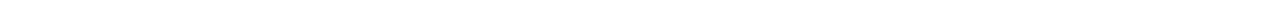
Figure 3 | DNAJB1 is a downstream transcriptional target of FOXE3 and is indispensable for the cell cycle. ( a ) Schematic illustration of the 5 0 UTR of DNAJB1 with golden boxes indicating potential FOXE3-binding sites predicted by ProSuite algorithms. Blue arrows, designated 1–8 F and 1–8 R, represent eight primer pairs used for amplifying regions of interest. ( b ) Amplification of specific segments in the 5 0 UTR of DNAJB1 using pull-down DNA as the template in the amplification reaction. ( c ) HEK293FTcells were transiently transfected with the DNAJB1 -GLuc-SEAP vector and an expression vector harbouring wild-type or mutant (p.E103K, p.N117K and p.C240*) FOXE3 alleles. Error bars represent percent deviation in each data set of luciferase activity normalized against SEAP performed in seven independent replicates for each condition. ( d ) HEK293FT cells were transfected with the wild-type or mutant FOXE3-expressing plasmids in a pT-Rex-DEST30 vector and expression levels of DNAJB1 were quantitated with TaqMan assays. Error bars represent s.d. in each data set of the DNAJB1 expression normalized against GAPDH, analysed in six independent replicates. ( e ) HLE cells were transfected with either scrambled (i–iii) or DNAJB1 shRNA (iv–vi), and the increase in apoptotic cell population in response to shRNA-targeting DNAJB1 was assessed 48h post transfection. ( f ) Increased apoptosis resulting from downregulation of DNAJB1 was estimated through flow cytometry of TUNEL stained cells 48h post transfection of DNAJB1 shRNA. The loss of DNAJB1 results in increased apoptosis in HLE cells resulting in a threefold increase in TUNEL-positive cells compared with the control cells transfected with scrambled shRNA ( P o 0.000005; 2-tailed student’s t -test). Error bars represent s.d. in each data set analysed in four independent replicates. ( g ) The effect of the downregulation of DNAJB1 on the G0 population was examined through flow cytometry of propidium iodide-stained cells 48h post transfection of DNAJB1 shRNA. The DNAJB1 shRNA-transfected cells exhibited a significant increase in the G0 population as compared with the control cells transfected with scrambled shRNA. Error bars represent s.d. in each data set analysed in four independent replicates. ‘***’ indicates P o 0.00001 (two-tailed student’s t